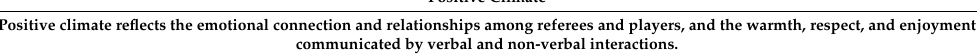
Table 1. Example of determining the assessment for the dimension of positive climate of the REFASS tool (based on Pianta, Hamre, Mintz